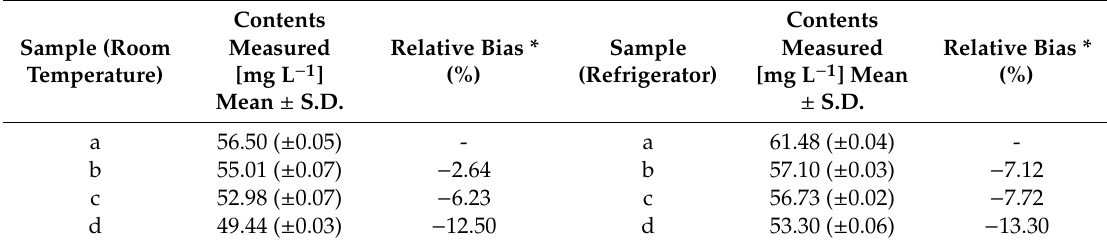
Table 2. Stability (%) of thiocyanate (SCN − ) in saliva samples storage at room temperature and at refrigerator (6, 24, 48 h) ( n =